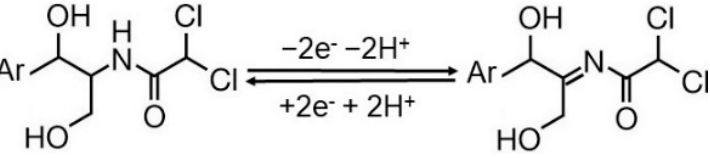
Table 2. Comparative performance characteristics of MIP(EBT) modified carbon-based sensors for EIS detection of